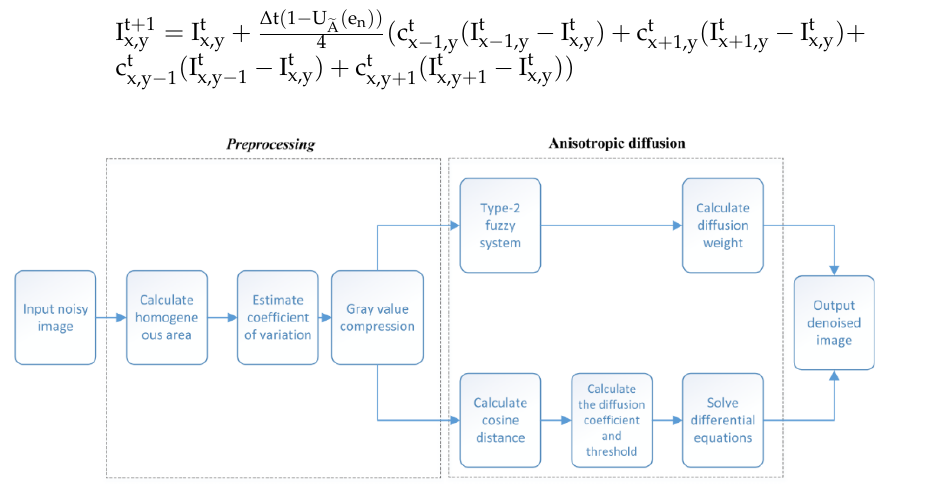
Figure 9. Membership function diagram.